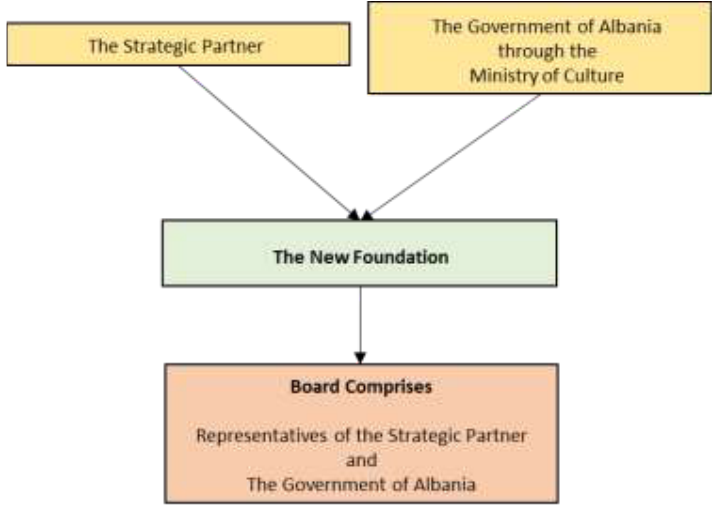
Figure 18: The New Foundation, proposed founding members